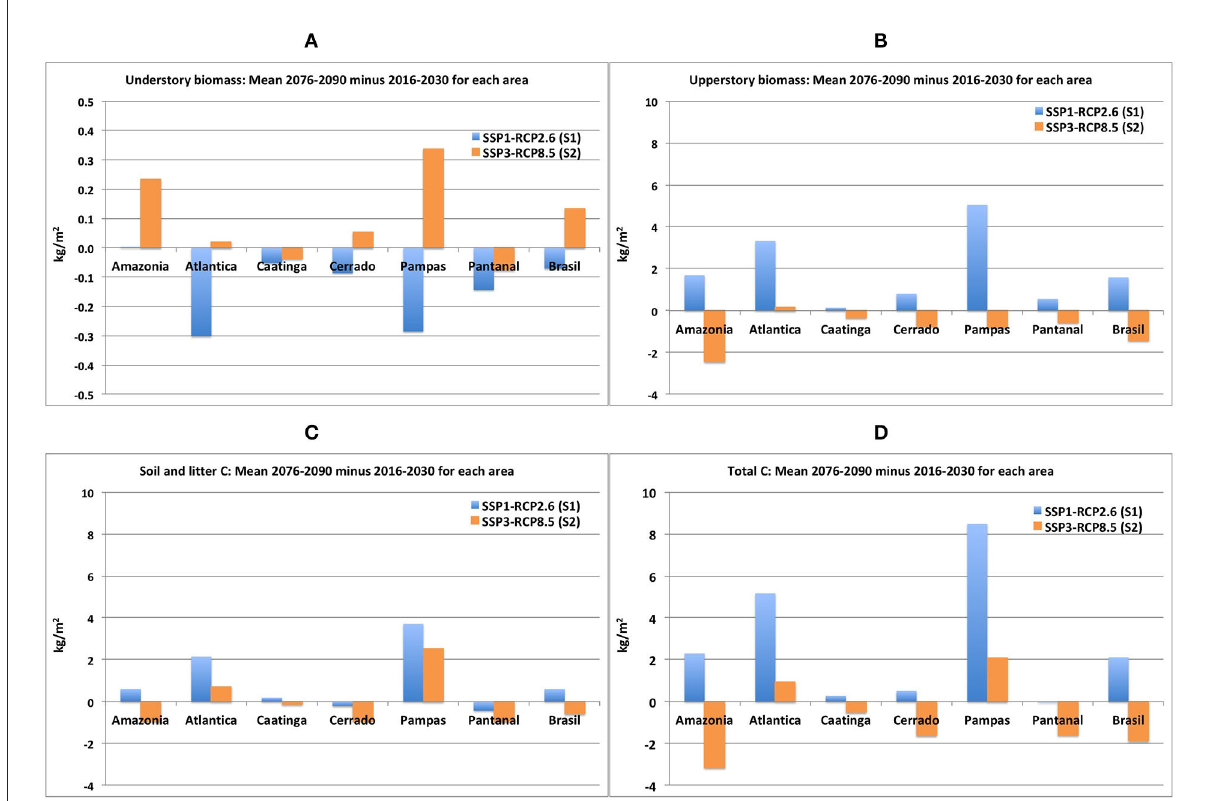
FIGURE6 Difference (kgC/m 2 ) between the mean of the last and first 15 years of the simulation for each biome for (A) understory, (B) upperstory, (C) soil and litter, and (D) total carbon stock for S1 (blue bars) and S2 (orange